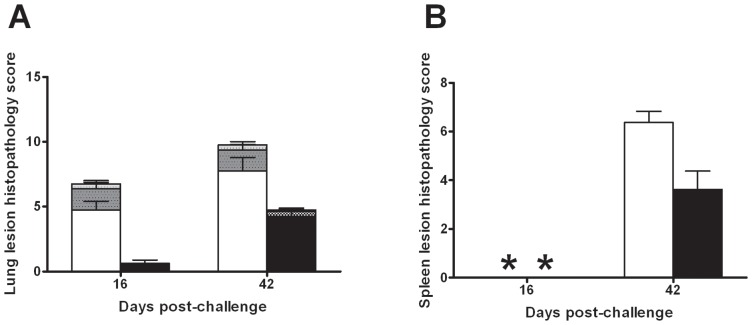
Subjective histopathology scores of post mortem at 16 and 42 days post aerosol challenge.Lung in Panel A) and spleen in Panel B) challenged with either exponentially growing culture (white) or NRP cultures of M. tuberculosis (black). Bars indicate group mean of 8 animals. Histopathological changes in the lung were recorded either as consolidated (no-shaded bars), necrotic (heavy-shaded bars) or calcified (light shaded bars). Spleen scores for each animal comprise number, size, and foci of necrosis and calcification.